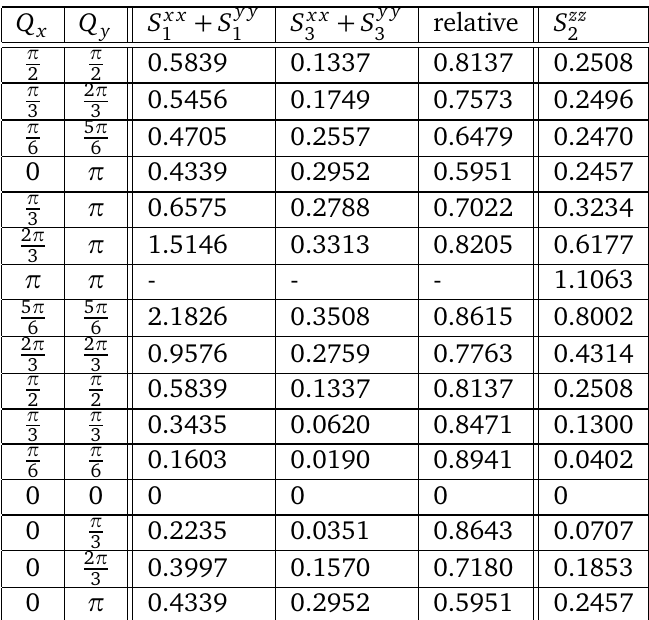
Table 1: Spectral weights extrapolated to infinite system size for various channels at various high-symmetry points in the MBZ. The transversal channel comprises the one-magnon and the three-magnon channel. The third column shows the relative weight of the one-magnon channel, i.e., the ratio ( S xx